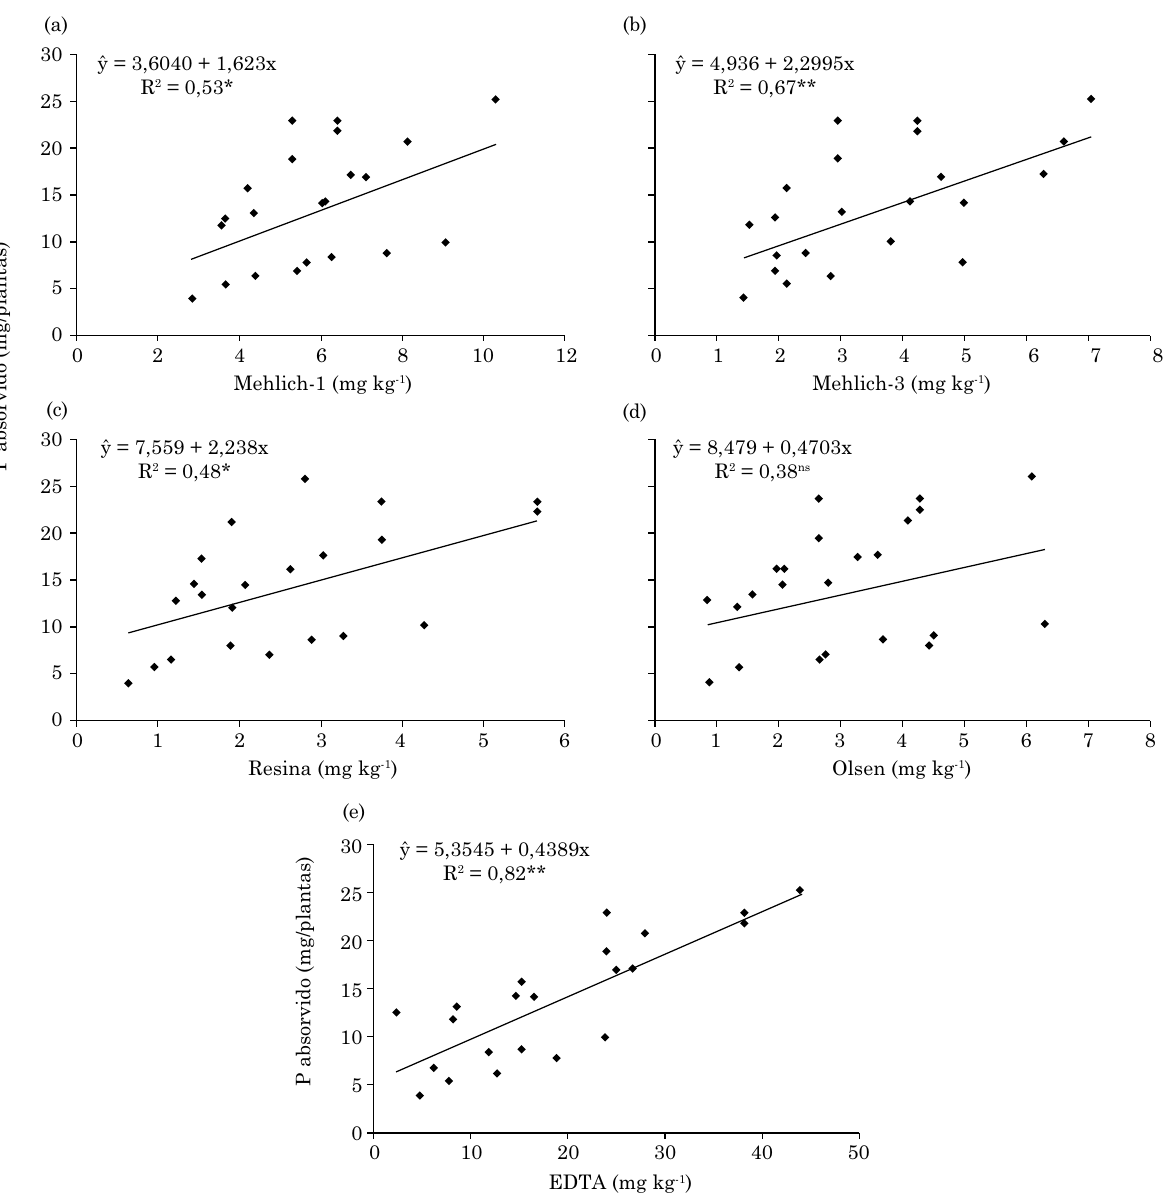
figura 2. correlação linear entre a quantidade de P absorvida pelo arroz e os teores de P extraídos dos cinco solos pelos métodos Mehlich-1 (a), Mehlich-3 (b), resina (c), olsen (d) e Edta (e). ns : não significativo; * e ** significativo a 5 e 1 % de probabilidade,